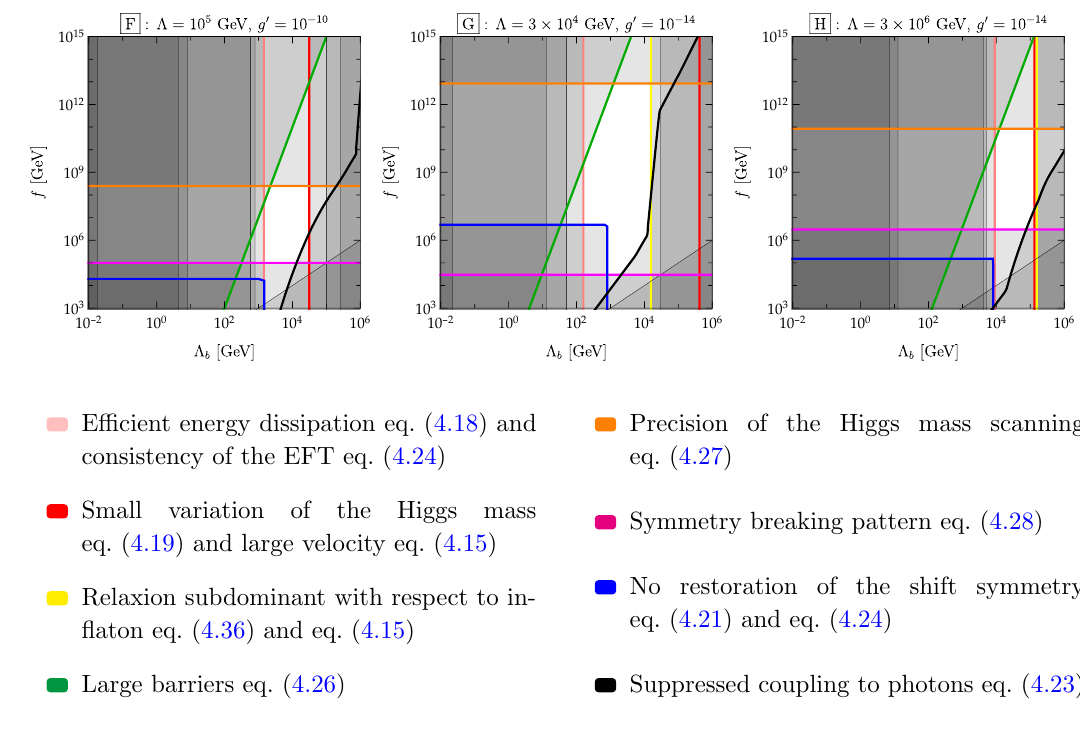
Figure 32 . Same as (cid:12)gure 31 (EW gauge boson production during in(cid:13)ation) but in the ((cid:3) b , f ) plane, for each benchmark point F , G , H . Here we only show the contours that do not depend on fragmentation. The new exclusion lines due to relaxion fragmentation are shown in (cid:12)gure 33.